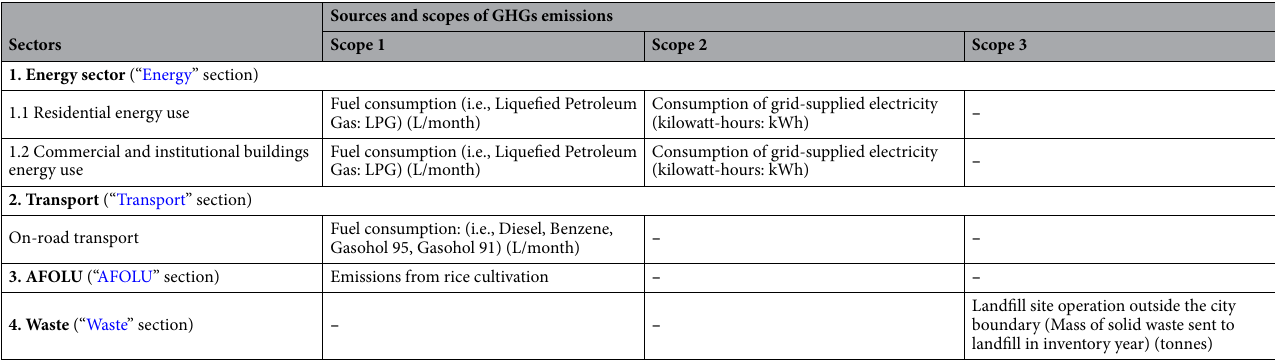
Table 1. Sources and scopes of city-level GHG emissions 10